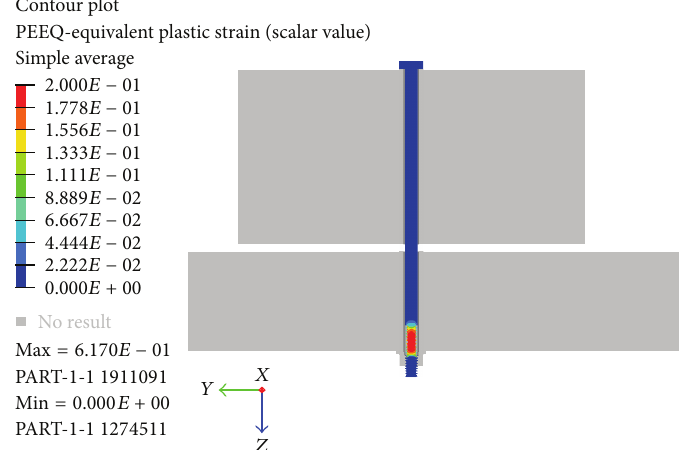
Figure 8: Contours of effective plastic strain at maximum applied displacement, detailed static tension model.